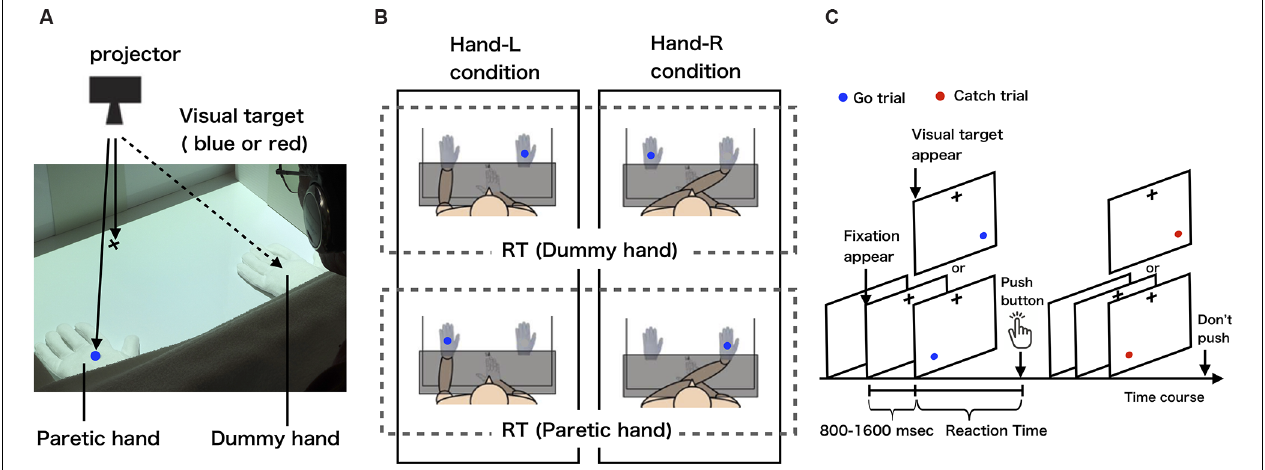
FIGURE 1 | (A) The measurement of body-specific attention to the paretic hand. (B) Experimental conditions and definition of body-specific attention (each condition is circled by a solid line; dummy or paretic hand reaction time is circled by a dotted-line). These schematic views show the hand-L and hand-R conditions for patients with left hemiparesis. The patients placed their paretic hand either on the left side (hand-L) or right side (hand-R). In both conditions, the dummy hand was placed on the opposite side of the midline to the paretic hand. For patients with right hemiparesis, the paretic hand was placed to the left of the midline in the hand-L condition and to the right of the midline in the hand-R condition. We defined the amount of body-specific attention directed to the paretic hand as the average reaction time for when the visual target was presented on the dummy hand minus the average reaction time for when the visual target was presented on the paretic hand (body-specific attention = dummy hand − paretic hand). (C) Visual detection task. After the presentation of a fixation point, the visual target appeared randomly from 800 to 1,600 ms, on one of the two hands (paretic or dummy hand). Participants pushed the button only when a blue-filled circle appeared.